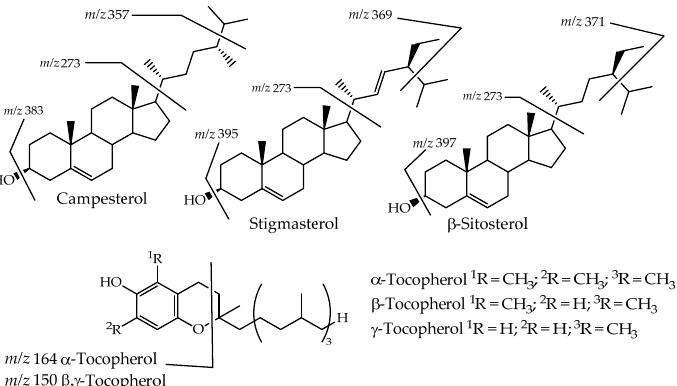
Figure 3. Chemical structure of the phytosterols and tocopherols, and their most significant fragments observed on GC-MS spectra. The second and the third most abundant compounds are fatty acids, respectively pal- mitic and linolenic acids; both acids contribute to the species valorization and, from pre- vious studies, we demonstrate that they can contribute to the species’ survival under sa- linity stress [18]. Another interesting result is the occurrence of inositol, mainly the myo - inositol isomer. Mahajan and Tuteja [32] described inositol phosphates as messengers to modulate the intracellular calcium level, an essential parameter in reducing osmotic stress. Other studies described the role of myo -inositol in salinity stress and established that it could help the plant defenses by participating in its antioxidant system and also regulate the ionic homeostasis [33]. 3.2. LC-MS Profile The chemical profile of the L. vulgare ethanolic extracts was established using UHPLC-DAD-ESI/MS 2 analyses. It was possible to confirm that the aerial parts are quite similar in the type of compounds present (Figure 4), but different in their amounts (Table 2). Table 2. Chemical composition of L. vulgare ethanolic extracts. Retention time (t R ; min), wavelengths of maximum absorption ( λ max ; nm), deprotonated molecular ion ([M − H] − ; m / z ), mass spectral data (MS 2 ; m / z ) indicating in parentheses relative intensity, quantification in mg g − 1 ± SD a . Proposed Compound